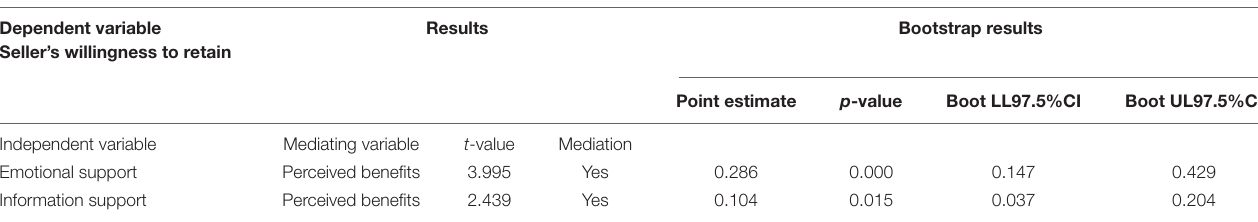
TABLE 6 | Summary of the tests of mediating effects.